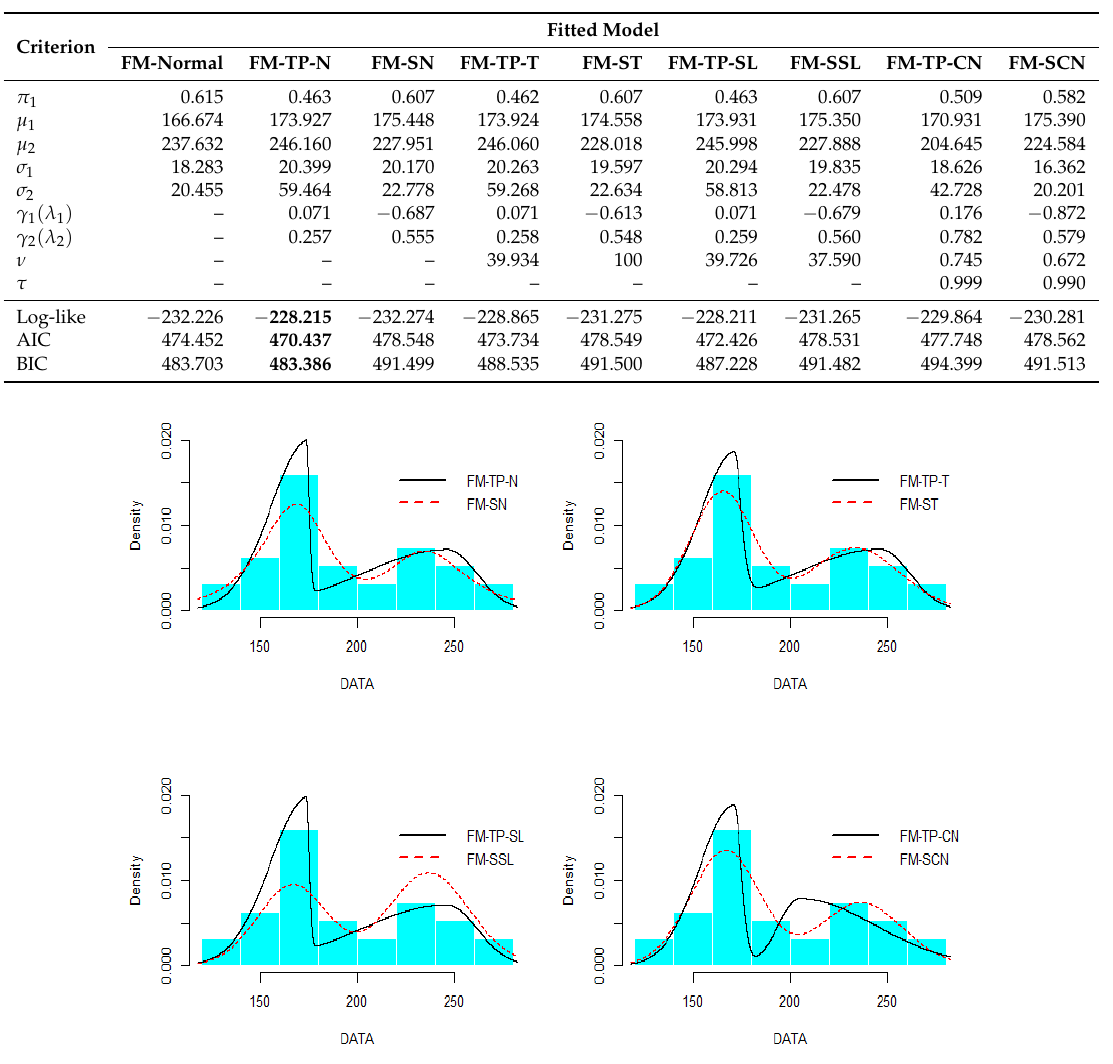
Figure 3. Histogram of UScrime data with fitted FM-TP-SMN and FM-SMSN models with two